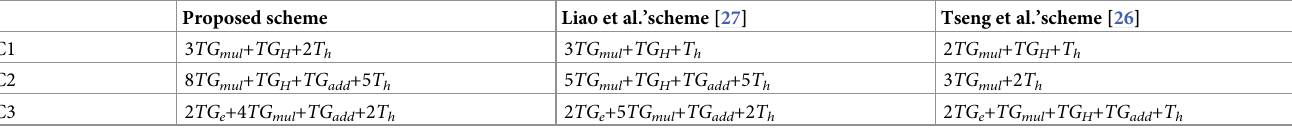
Table 2. Computational cost comparison of our scheme with other schemes.